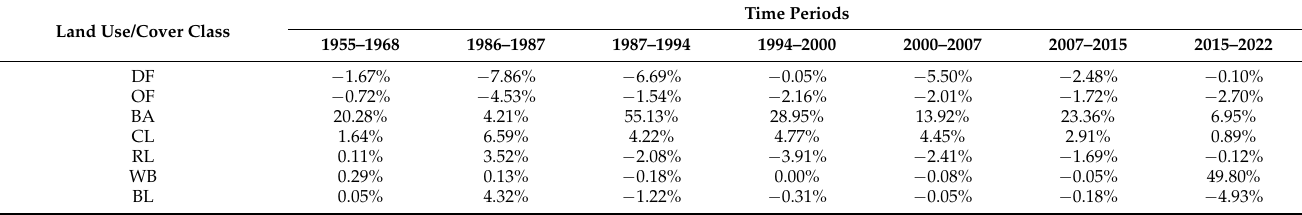
Table 4. Land use/cover classes change rates between the studied time